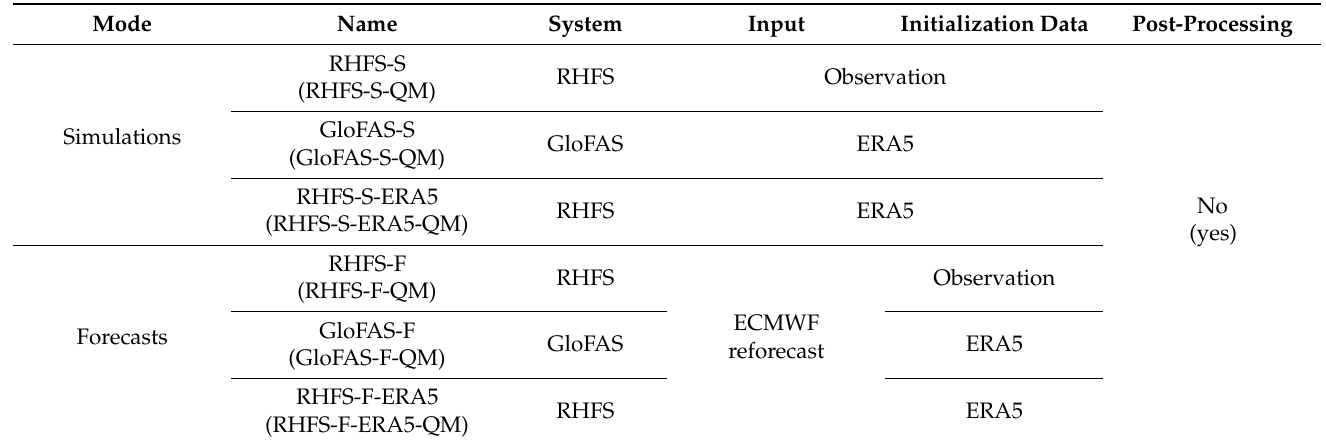
Table 1. Name, system, input, initialization data and post-processing of simulations and forecasts used in this study; the versions that use quantile mapping are in